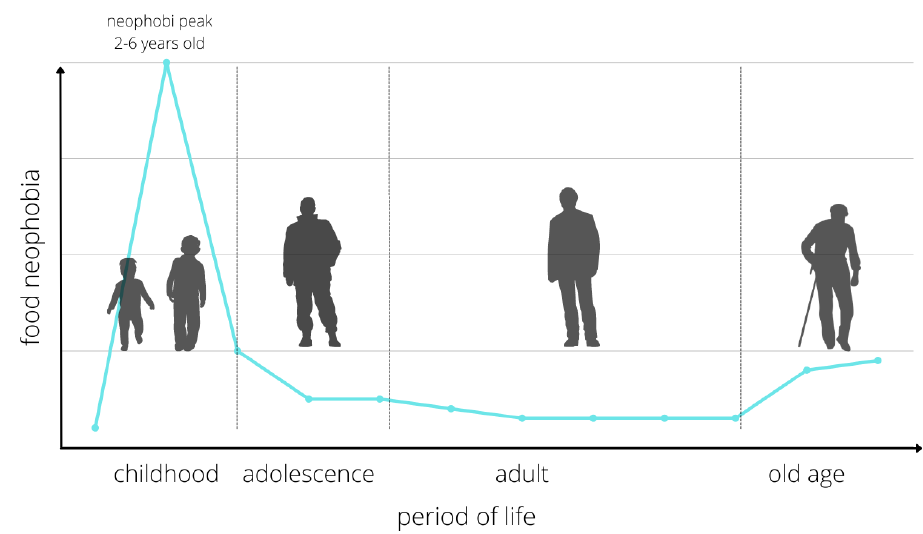
Figure 1. Changes in the level of nutritional neophobia in different periods of life. Source: Own elaboration based on Kozioł-Kozakowska and Piórecka (2013, p. 2).